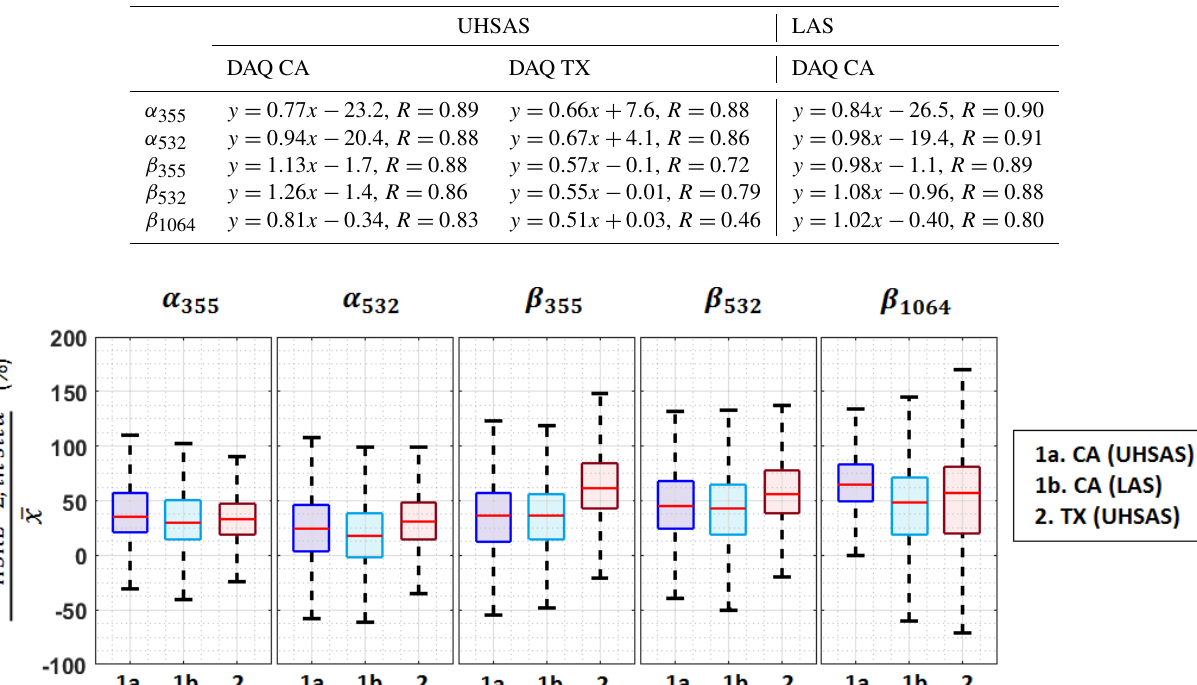
Figure 9. Statistics of bias observed between HSRL-2 measurements of extinction ( α ) and backscatter coefficients ( β ) and those calculated from the adjusted in situ measurements and Mie theory for the DAQ CA data (using UHSAS and LAS) and for the DAQ TX data (UHSAS only). UHSAS measures the size distribution of sub-micron particles, while the LAS measures the size distribution of sub- and super-micron